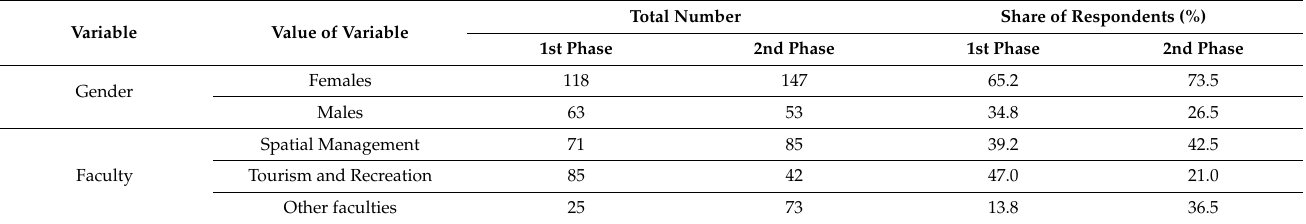
Table 1. General characteristic of respondents in the surveys, 1st phase = 181, 2nd phase =